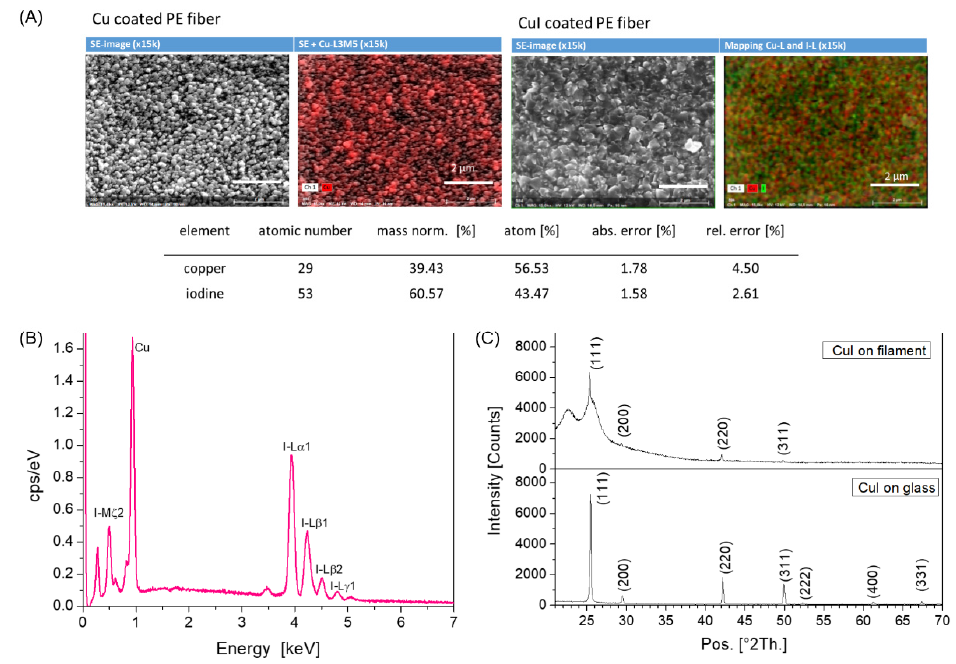
Figure 3. ( A ) EDX mapping of a coated PE fiber—SE image and Cu-L und I-L mapping, 12 kV, magnification: ×15,000; the EDX mapping shows both Cu-rich and J-rich spots. ( B ) EDX spectrum of CuI taken from the PE fiber, 12 kV, 500 s; ( C ) XRD spectra of 500 nm thick CuI on a PE fiber (ref. card ICDD 01-083-1108) in comparison to 800 nm CuI with sputtered Cu on a glass substrate (ref. card ICDD 01-085-1326).